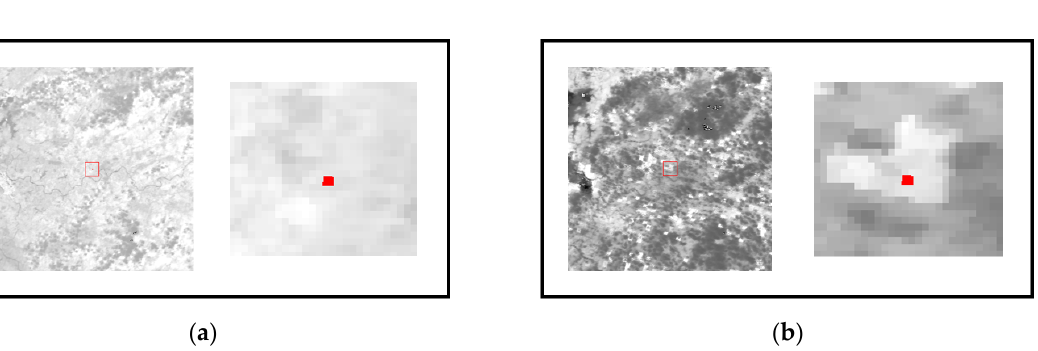
Figure 2. NDVI images generated from MODIS products, the red ROI refers to the corresponding study area. ( a ) Image of 30 April 2014, which indicates the smallest NDVI value in the growing period of that year. ( b ) Image of 8 July 2014, which indicates the largest NDVI value in the growing period of that year.